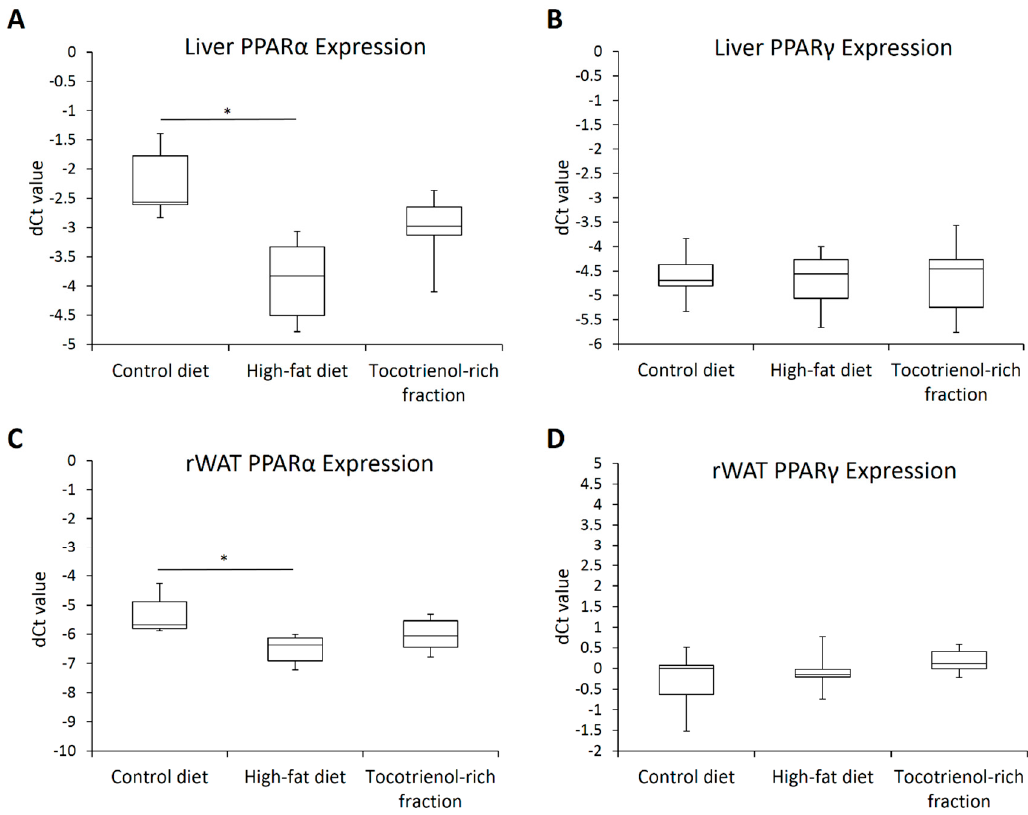
Figure 8. Box-and-whisker plots of normalized Ct values (dCt) of PPAR α and PPAR γ in the liver ( A , B ) as well as retroperitoneal adipose tissue ( C , D ) of the rats assigned to different treatment groups. Hypoxanthine phosphoribosyltransferase 1 (HPRT1), succinate dehydrogenase complex flavoprotein subunit A (SDHA), and β -actin (BAC) were used as the endogenous reference genes. Sample size was n = 7 per group. * Indicates p < 0.05 between groups. PPAR: peroxisome proliferator-activated receptor; rWAT: retroperitoneal white adipose tissue.